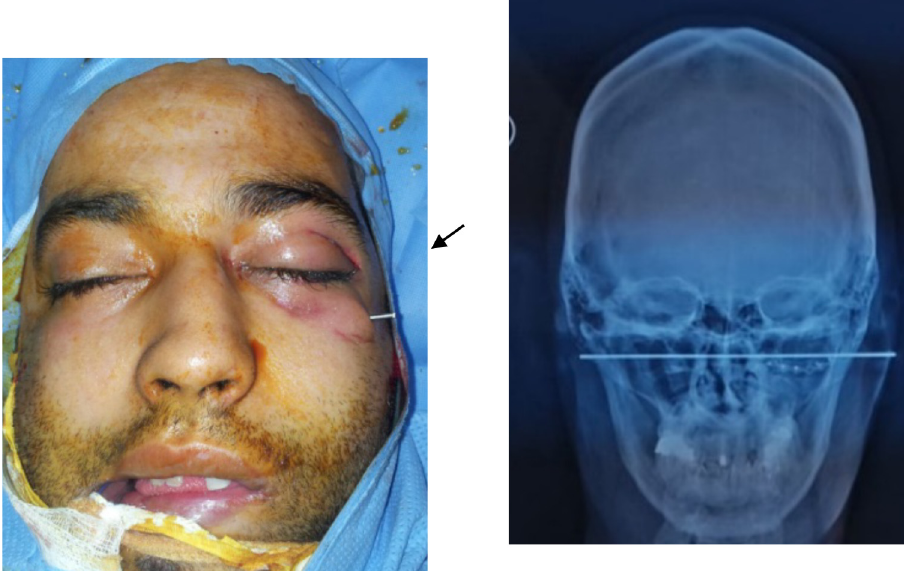
Fig. 4. Frontozygomatic constraint using a transfacial Kirchner pin (image of patient on the operating table to the left and that of the postoperative follow-up to the